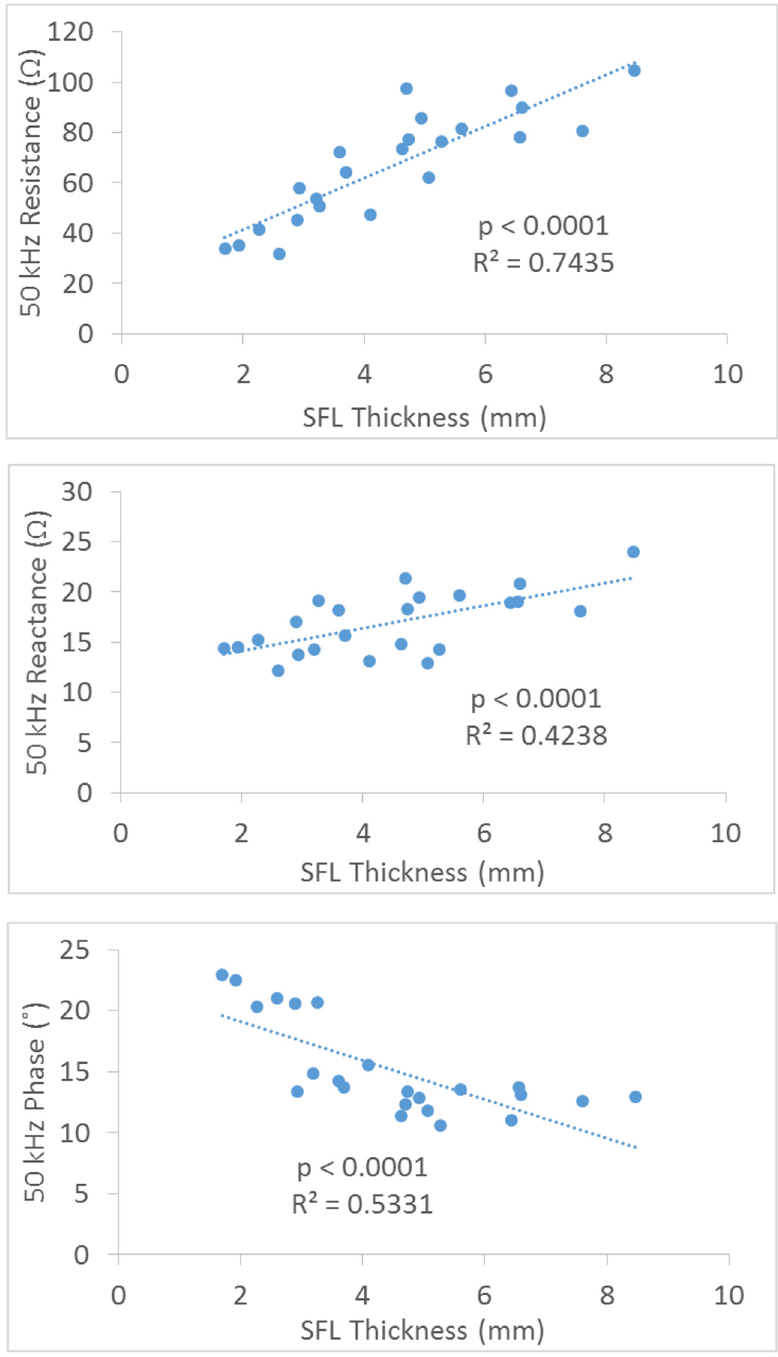
Fig 5. Correlation plots for the resistance, reactance and phase at 50kHz EIM versus SFL thickness using a narrow longitudinal configuration of electrodes.